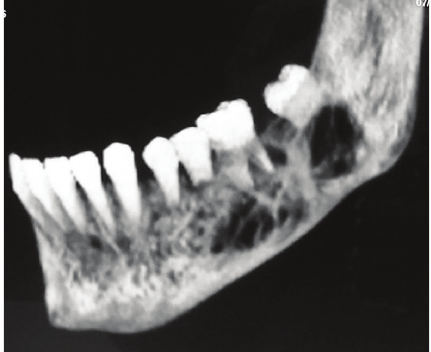
Figure 2: Preoperative CT scan.